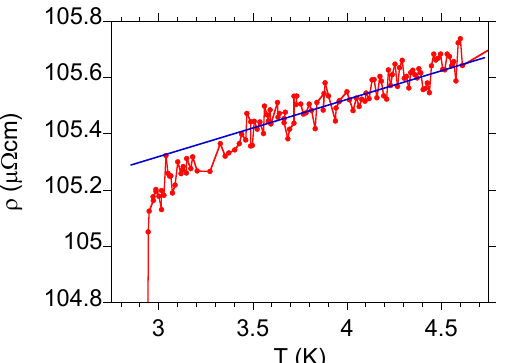
Figure 6. Resistivity of La 3 Rh 4 Sn 13 near the superconducting transition. The blue solid line indicates a linear decrease of ρ when the temperature decreases. Note, that close to T ∗ c , the resistivity decreases faster than linearly, which may indicate formation of disconnected superconducting regions. These give the superconducting transition a percolation path upon